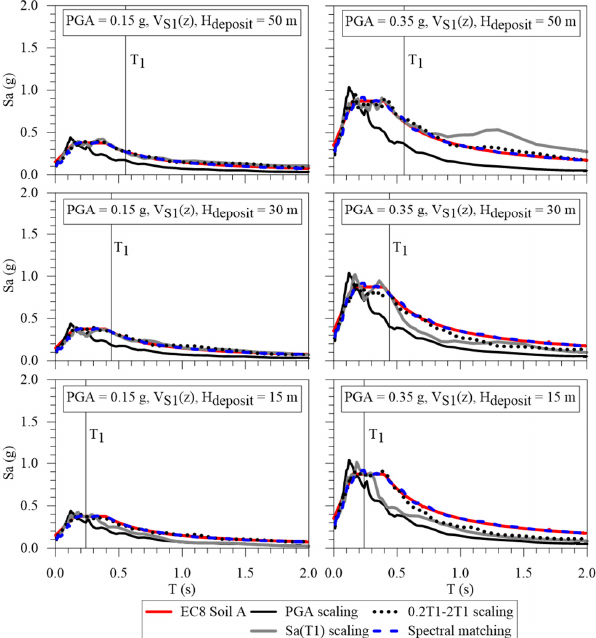
Figure 3. Mean response spectra of the input motions selected, according to 4 different selection strategies for PGA equal to 0.15 g and 0.35 g, and V S1 (z) profile. The response spectra going from the first line to the bottom one refers to a H deposit equal to 50, 30, and 15 m, respectively. Geosciences 2023 , 13 , x FOR PEER REVIEW